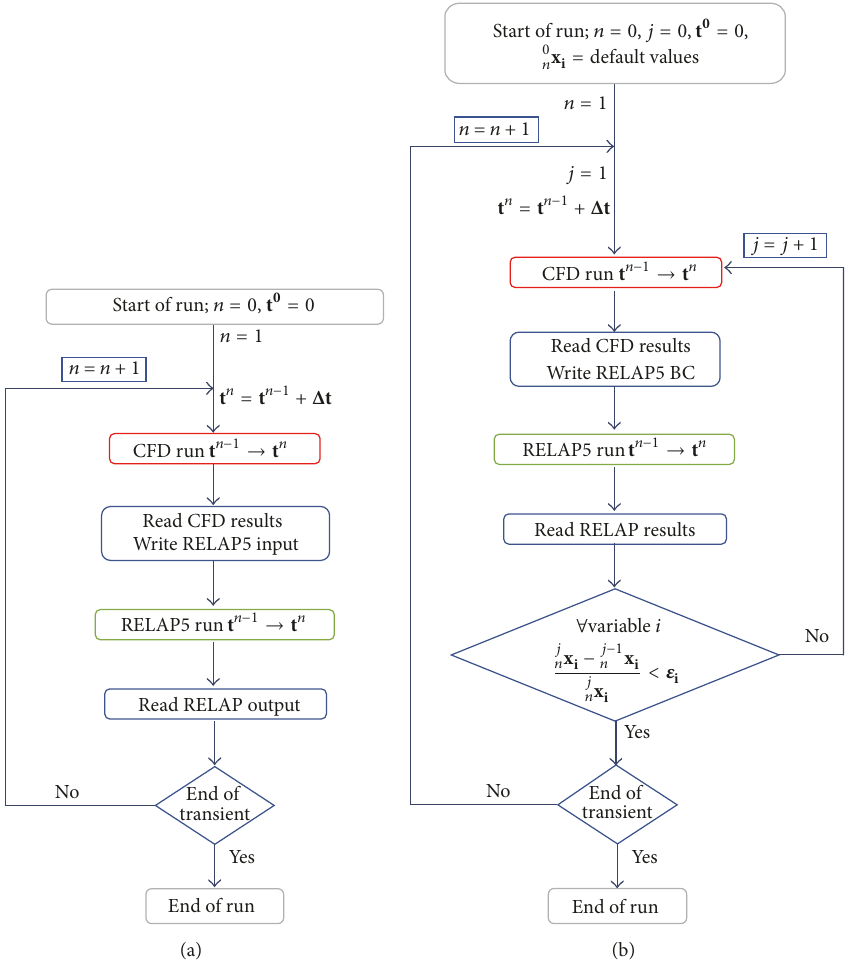
Figure 2: Logic of the explicit (a) and semi-implicit (b) numerical